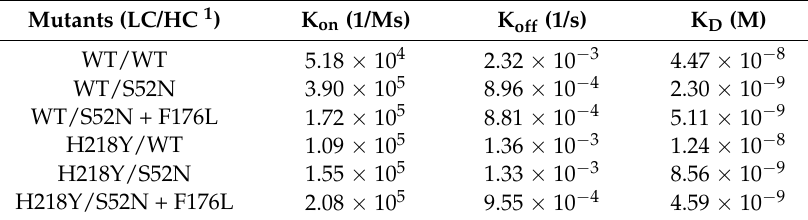
Figure 5. Statistics of HMGB1-GFP binding with mutant combinations (well displayed combinations). Gate N was chosen according to the center of the WT/WT cells, and half of the cell were in the gate. Compared with the WT/WT, combinations with better antigen binding will have higher percentage of cells in gate N. According to the results, light chain H218Y, D196Y + H218Y, and heavy chain L32V mutants have no significant contribution to antigen binding (Lower or similar percentage of cells in gate N compared with WT/WT). While the heavy chain S52N and S52N + F176L mutants significantly improved the antigen binding (higher percentage of cell in gate N). Table 2. Affinity of different